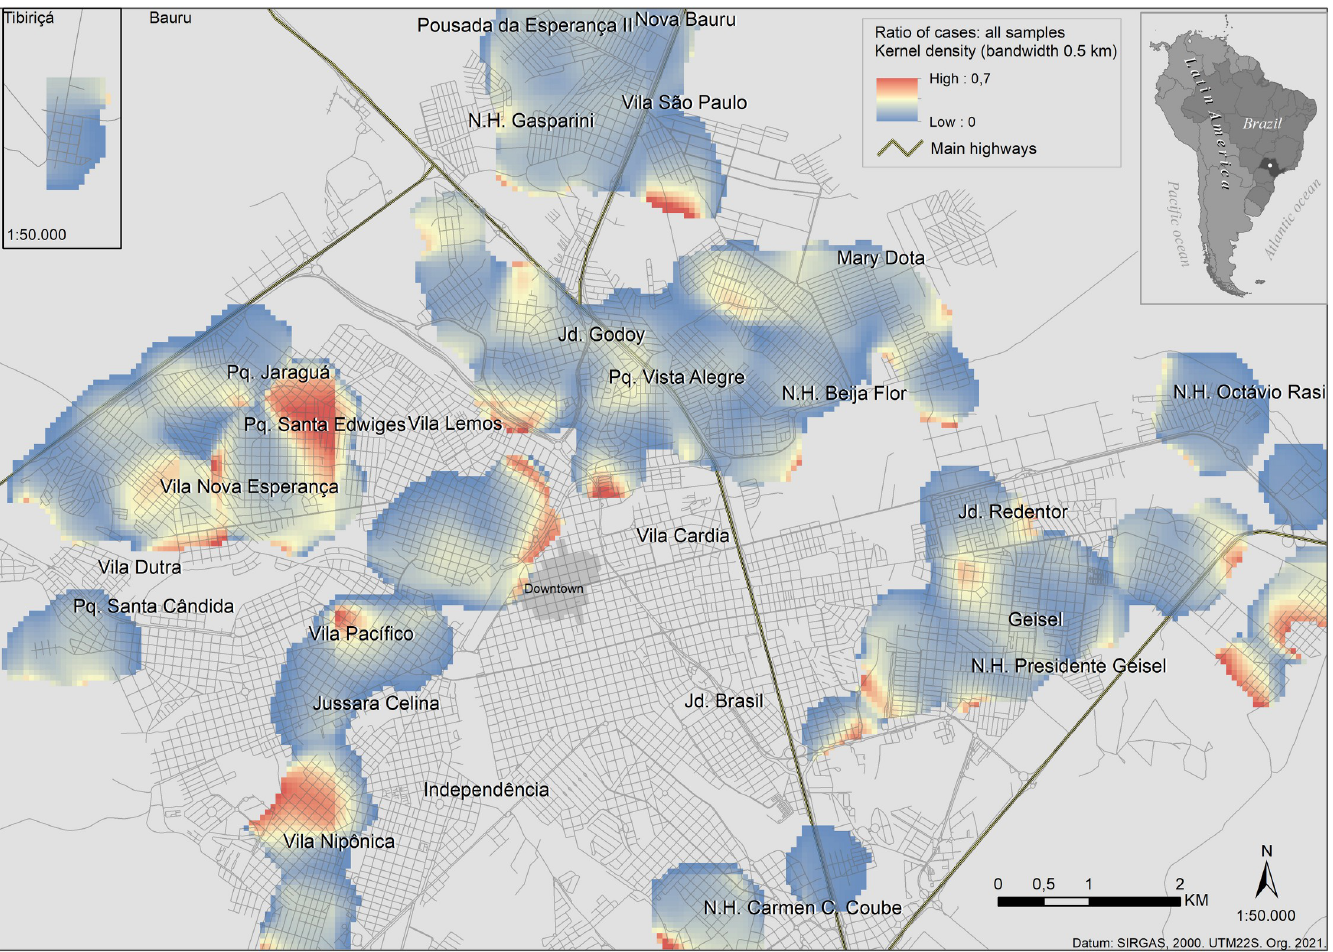
Fig 5. Kernel density ratio for canine visceral leishmaniasis. Kernel density ratio map ranging from 0 (blue) to 0.7 (red), which gives a visualization of the risk dividing the concentration of cases of CVL (S3 Fig) by the concentration of dog samples (S4 Fig). The areas of higher risk are in the west and southwest.